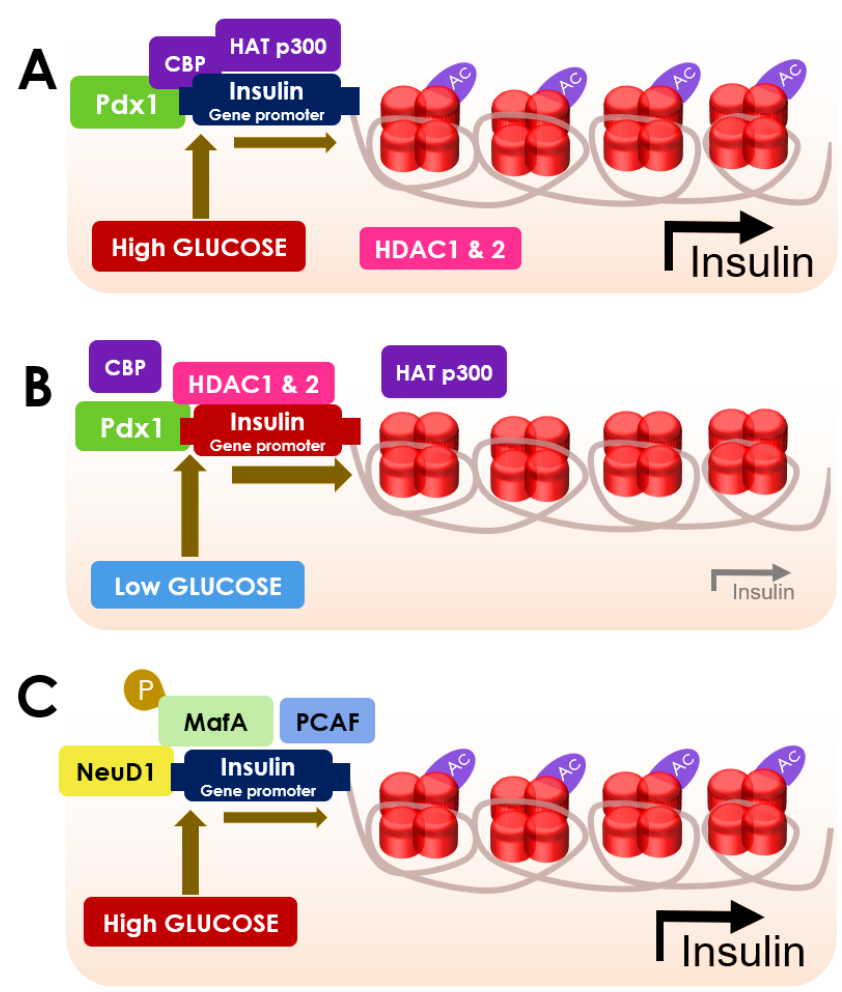
Figure 2. Schematic diagram showing the role of HDACs in regulating β cell function and insulin secretion. ( A ) Acetylation of histone H4 is increased in the insulin promoter when glucose levels are high due to the interaction of Pdx1 with CBP, HAT p300 (acetylated H4, relaxed chromatin and increased insulin expression); ( B ) Pdx1 recruits HDAC 1 and HDAC 2 to the insulin promoter when glucose levels are low, to inhibit H4 acetylation resulting in a decline in insulin production (deacetylated H4, tight chromatin and decreased insulin expression); ( C ) NeuD1 role in promoting insulin gene expression by the acetylation of p300-associated factor (PCAF) and MafA phosphorylation when glucose levels are